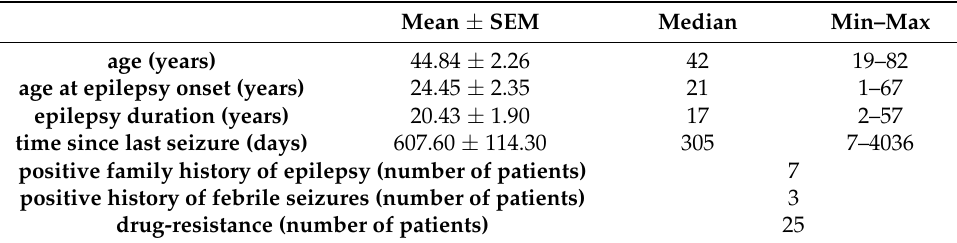
Table 1. Clinical and demographic characteristics of the